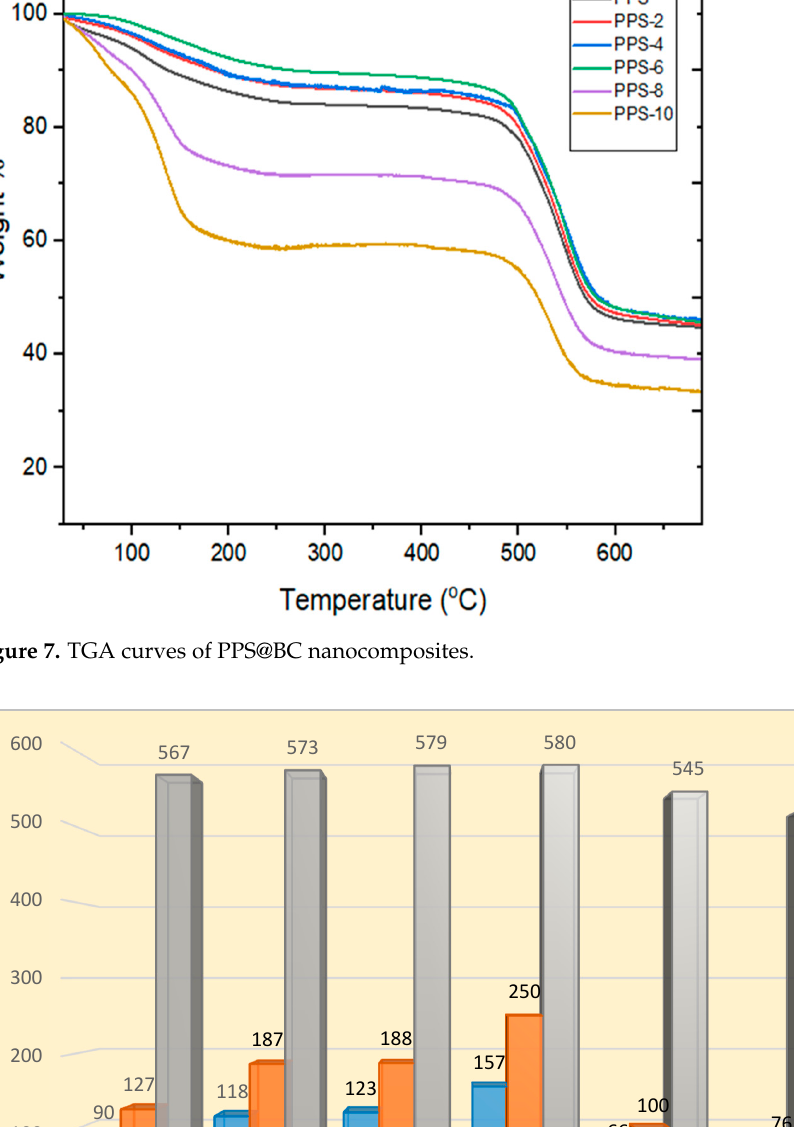
Figure 8. Comparative analysis T 5 , T 10 , and T 50 PPS@BC nanocomposites.